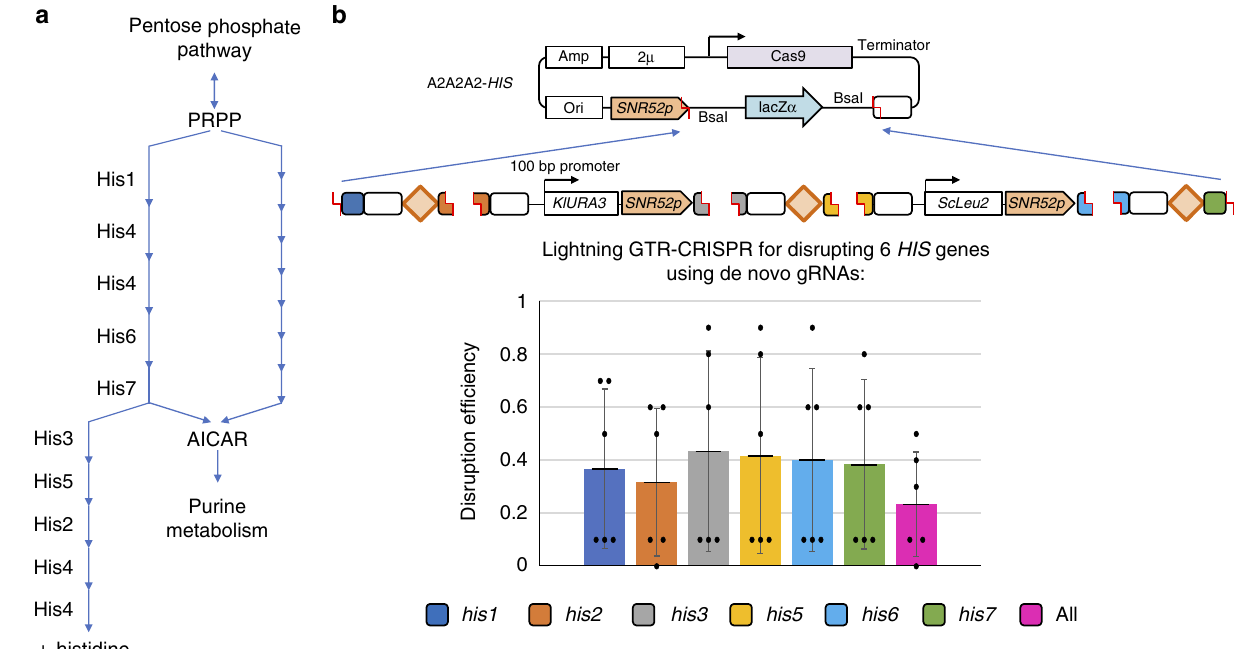
Fig. 5 Lighting GTR-CRISPR with un-optimized guide RNAs. a Graphic representations of the L-Histidine synthesis pathway. PRPP phosphoribosyl pyrophosphate, AICAR 5-aminoimidazole-4-carboxamide ribonucleotide. b Graphic representations and result of the Lighting GTR-CRISPR systems for six HIS gene disruptions. The data of bar charts represent mean averages of each gene or overall disruption ef fi ciencies. Each black dot represents the gene disruption ef fi ciency of 10 colonies from each biological replicate, and the error bars indicate the standard deviation of all ( n = 6) biological replicates. Source data are provided as a Source Data fi